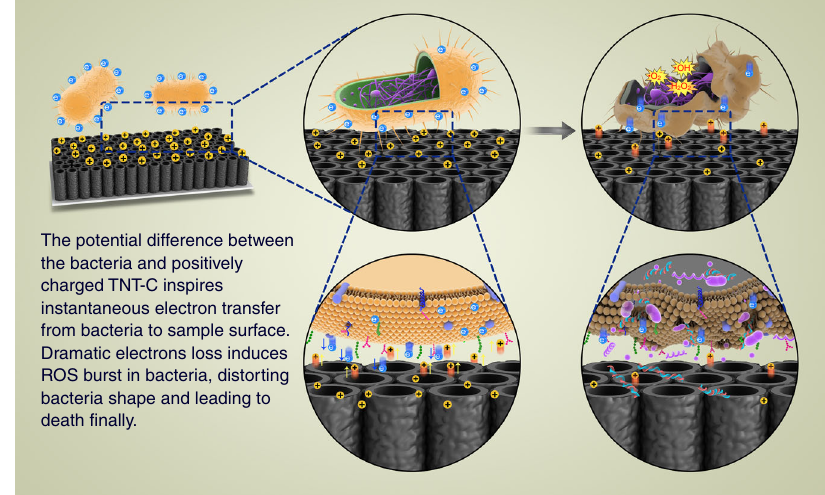
Fig. 8 Diagram showing antibacterial mechanism. Proposed antibacterial process on DC + charged TNT-C based on the